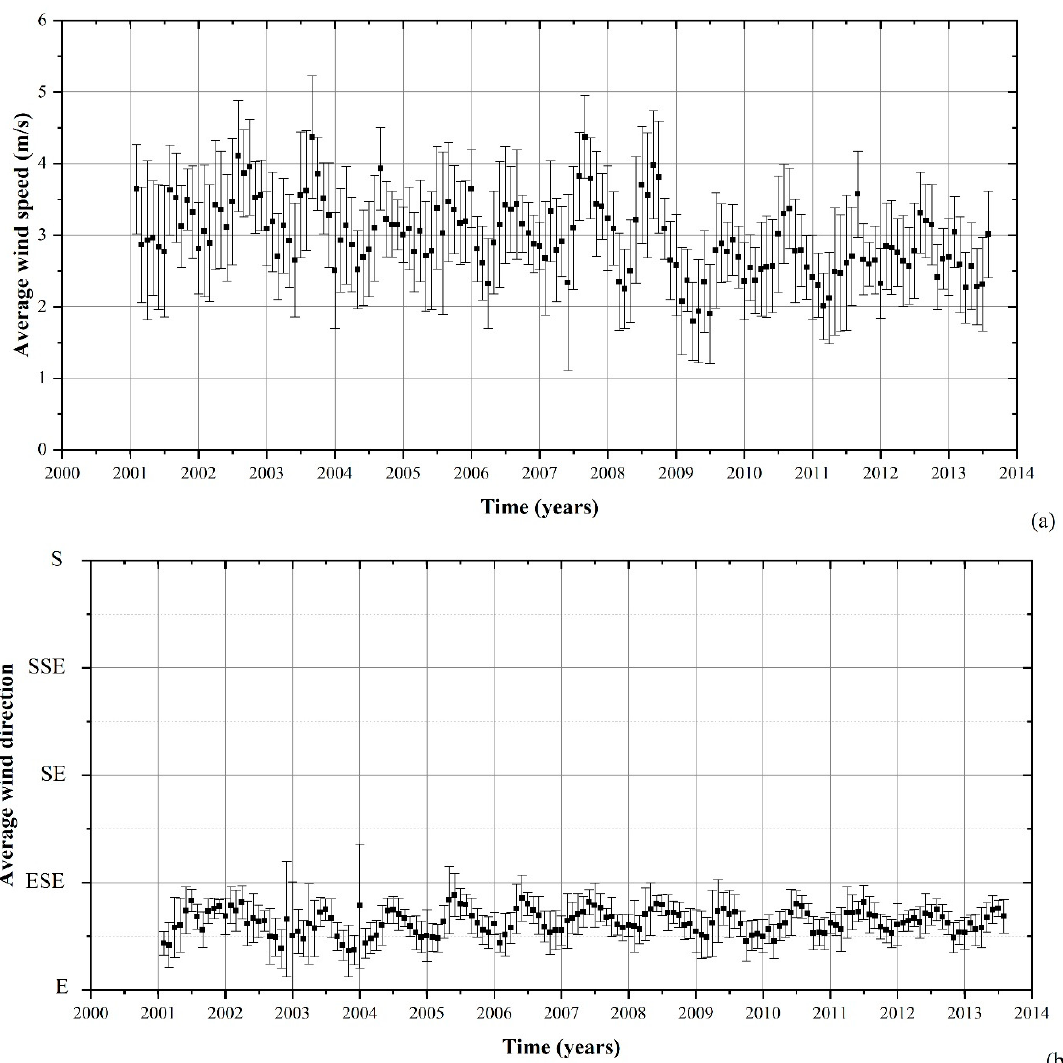
Figure 5. Monthly average wind speed ( a ) and monthly average wind direction ( b ).